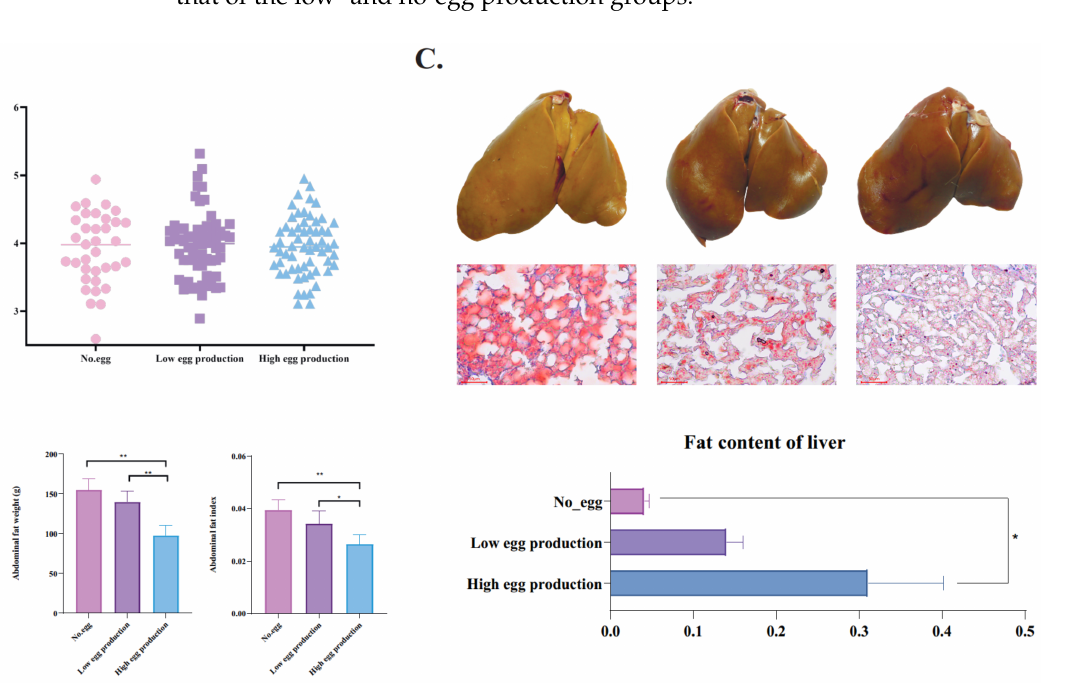
Figure 1. The lipid deposition patterns of geese with different laying performance. The body weight ( A ) and abdominal fat weight (index) ( B ) of different laying performance geese. ( C ) From left to right, the liver morphology and oil red staining sections of the high-egg production group, low-egg production group and no-egg group were in turn. Meanwhile, the OD values of oil red staining sections were counted. Data are shown as the mean ± standard deviation (SD). * means p < 0.05, and ** means p <